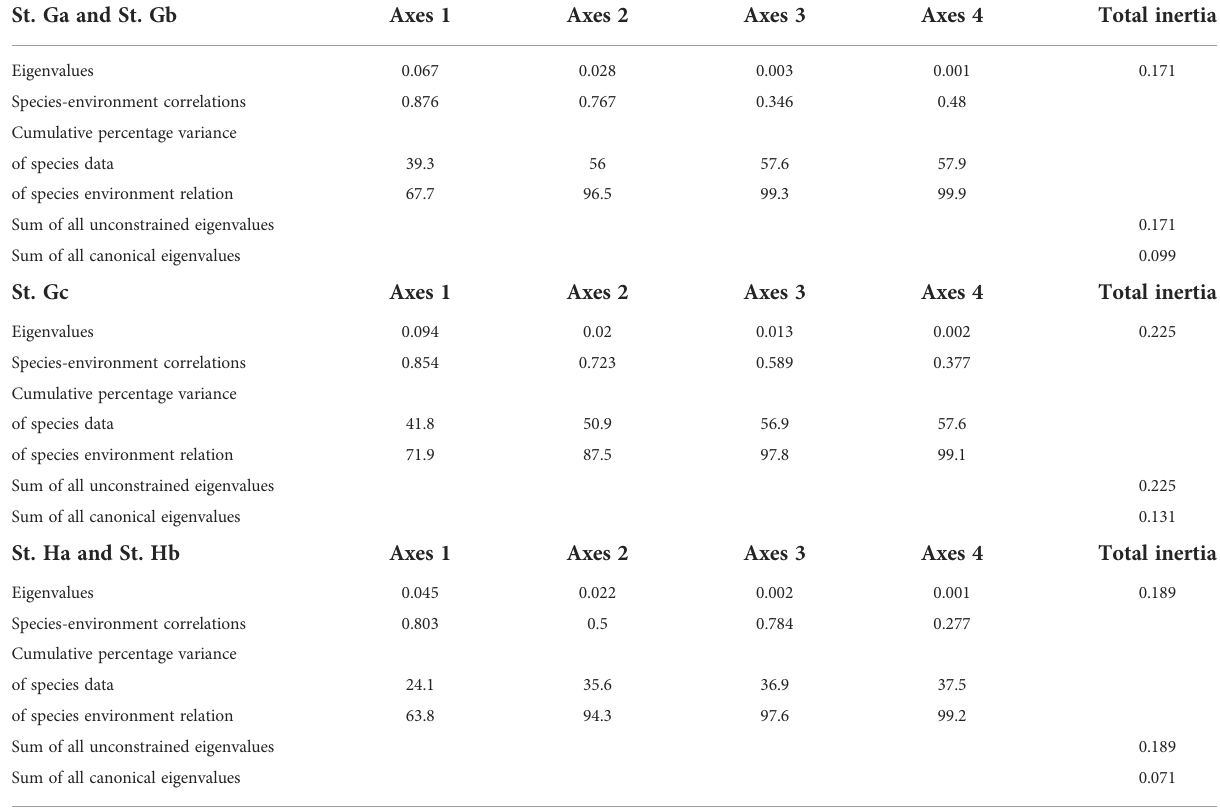
TABLE 1 Summary of the results from canonical correspondence analysis. St. Ga and St.